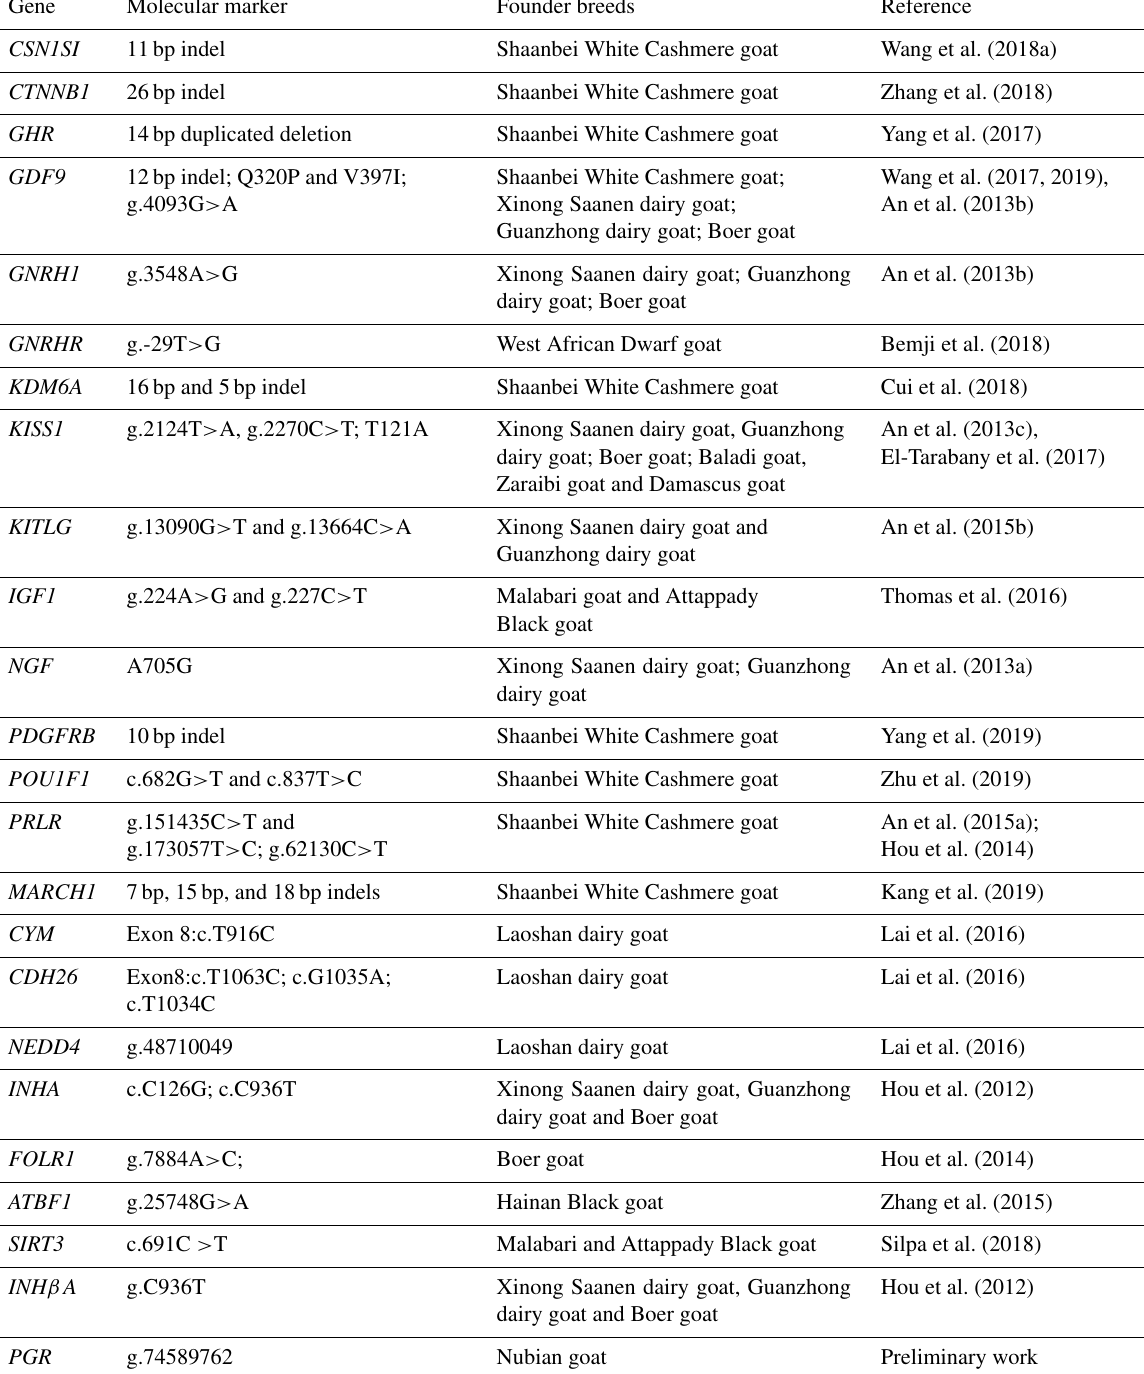
Table 1. Genetics variants associated with the fecundity in goat. Gene Molecular